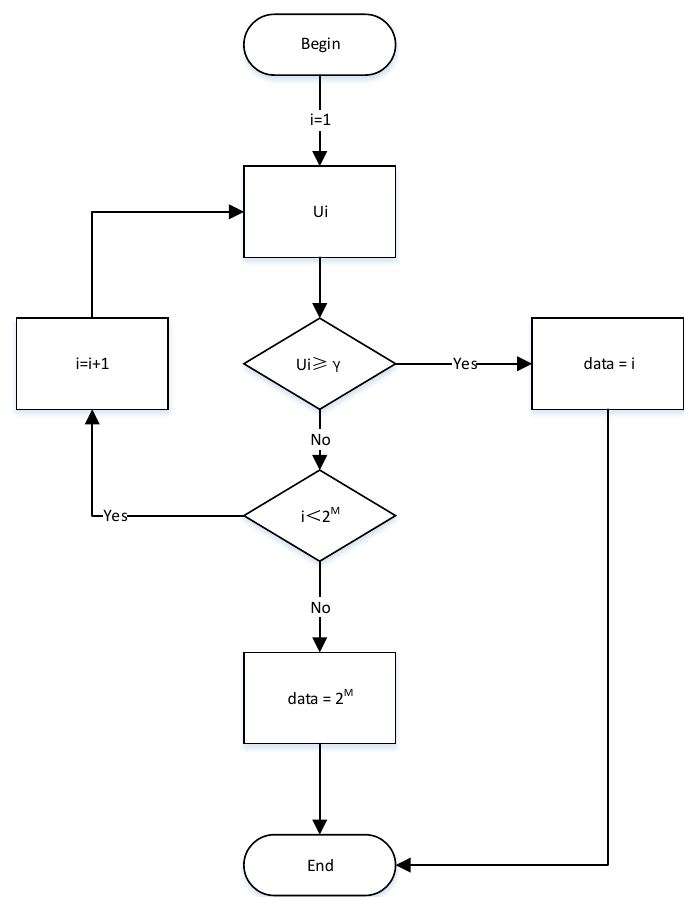
Figure 2. Symbol decision flow of a suboptimal receiver. 2.3. Optimal Noncoherent PPM Receiver The optimal PPM receiver also recovers the pulse signal through envelope detection and then determines the received information by judging which of the 2 M time slots the pulse signal is in. The decision process is shown in Figure